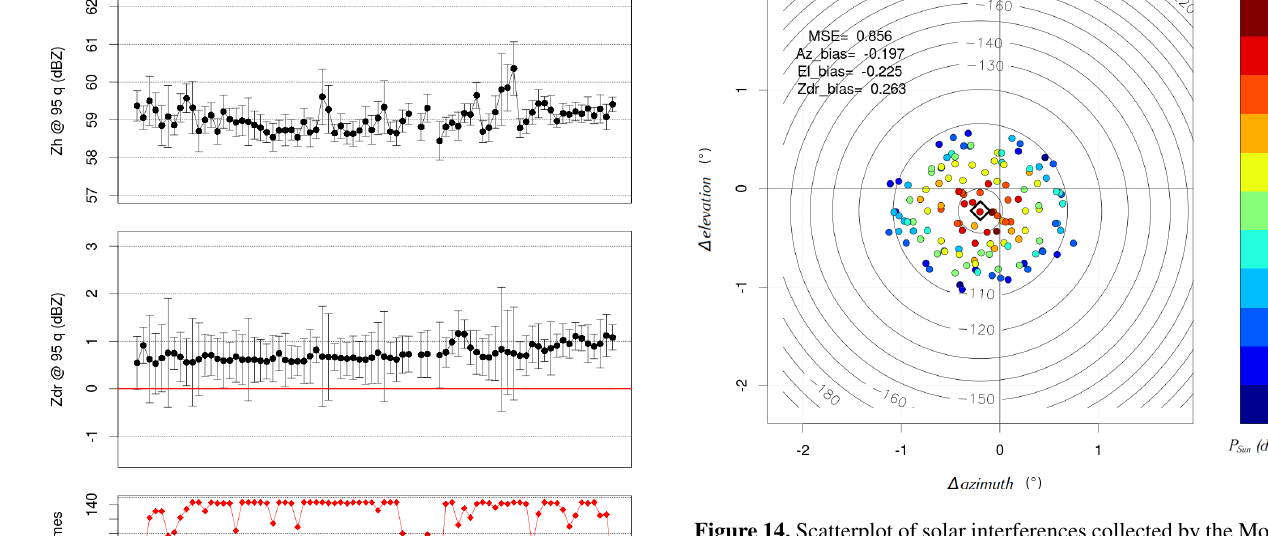
Figure 14. Scatterplot of solar interferences collected by the Monte Settepani radar during September 2014. The x axis represents the difference between the radar and Sun azimuths, the y axis the dif- ference between the radar and Sun elevations, and the colors the received power in decibel milliwatts (dBm). The isolines show the value of the received power in a given point on the (cid:49) azimuth– (cid:49) elevation plane, computed by the theoretical model fit. The black rhombus is the antenna pointing. The calculated bias in azimuth and elevation, the mean squared error and the Z dr bias are reported in the